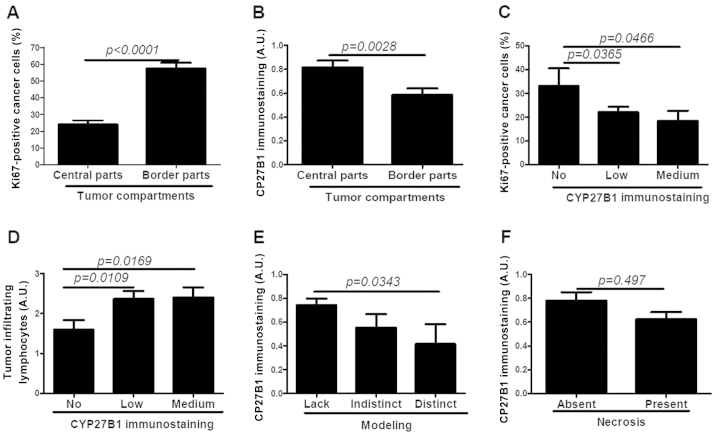
(A) Proliferation activity in the border and central parts of cancers. CYP27B1 immunostaining is associated with dynamism of tumor growth (B), Ki67 expression (C), stromal modeling pattern (D), lymphocyte infiltration (E) and necrosis (F). Statistically significant differences are denoted with p-values as determined by Student’s t-test. A.U., arbitrary units.